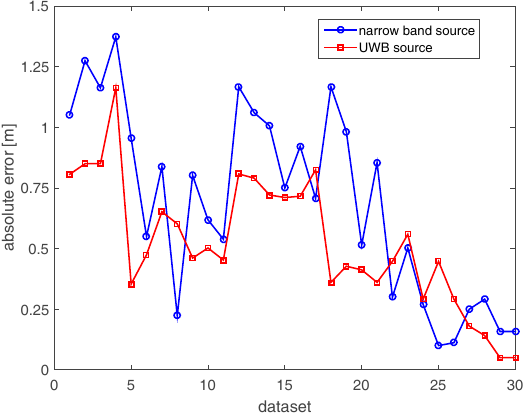
Figure 11. Positioning errors achieved with the tilted array (B).